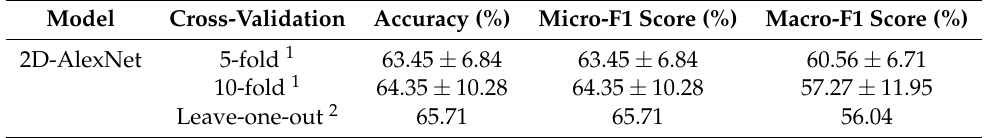
Table 2. Performance measures of the 2D-AlexNet model: accuracy, micro-, and macro-average F1 scores. Average cross-validated scores across all subsections of the